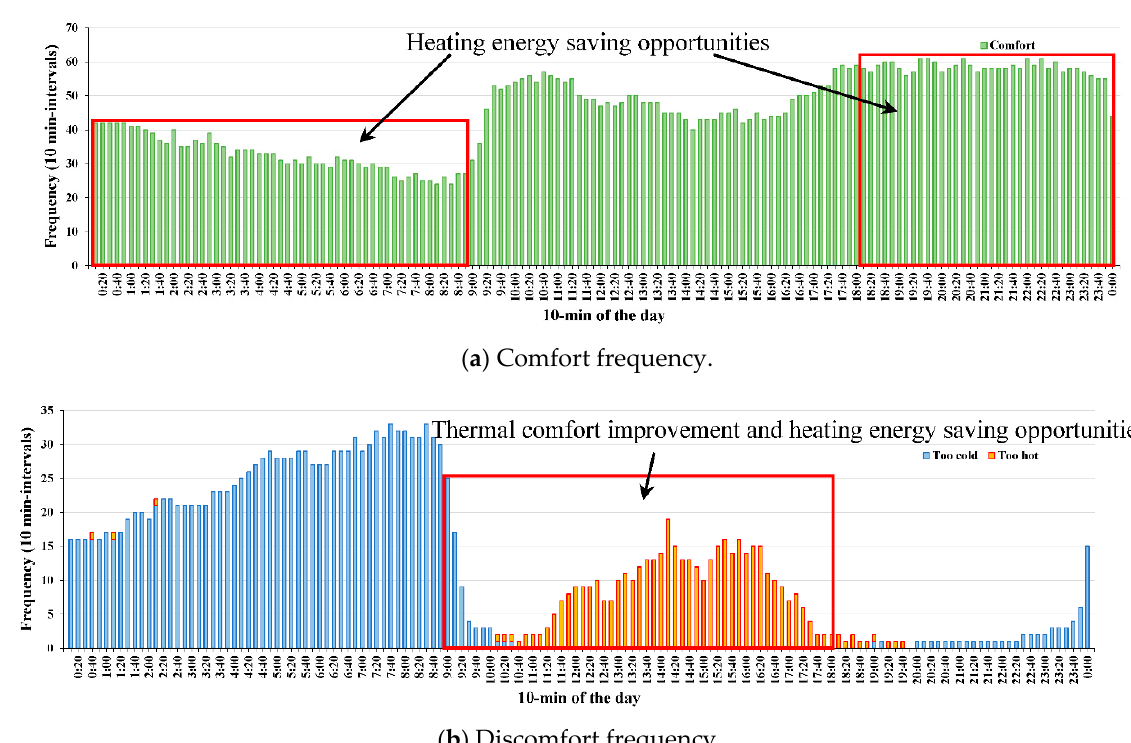
Figure 6. Frequency analysis during the winter comfort zone ( a ) and the winter discomfort zone ( b ).